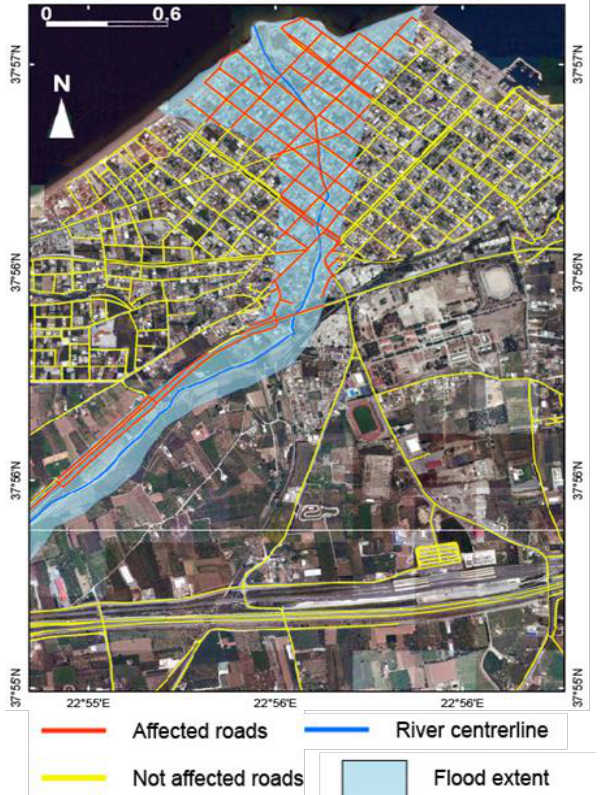
Figure 3. Maps of Xerias river basin near its outlet at the town of Corinth, illustrating the extent of flooding as mapped during the post-flood fieldwork, and the affected part of the road